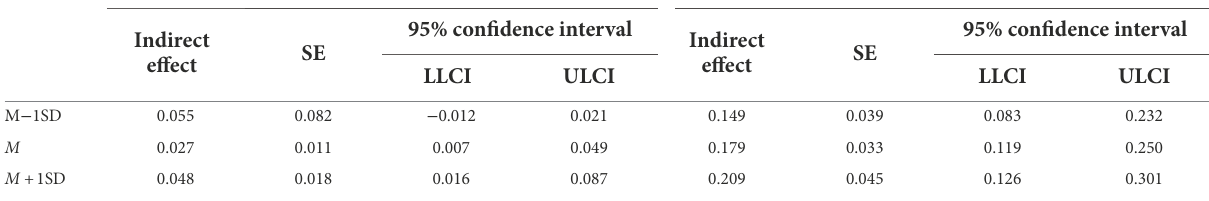
TABLE 8 Results of moderated mediating